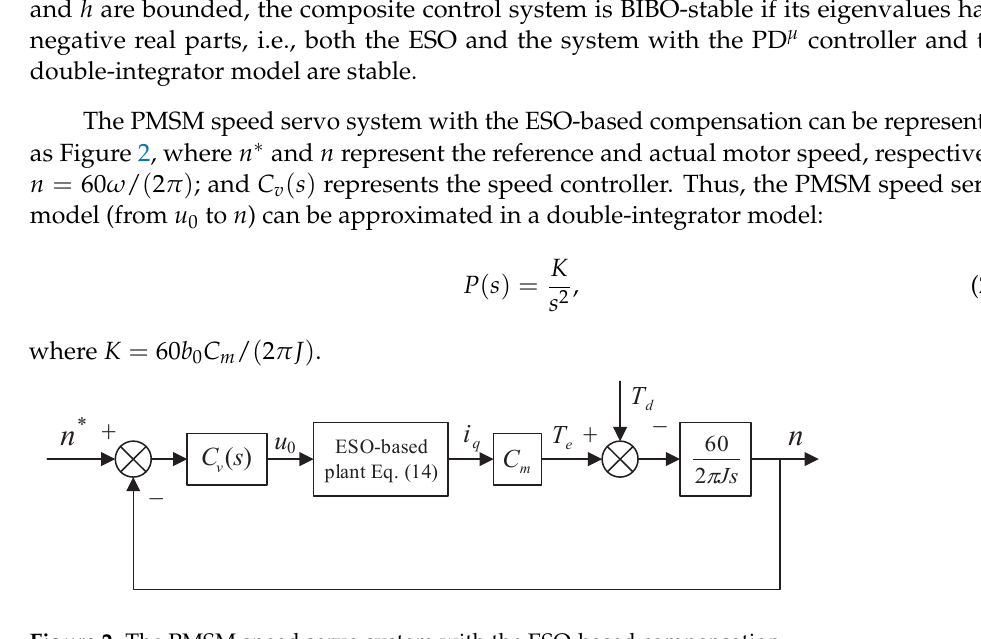
Figure 2. The PMSM speed servo system with the ESO-based